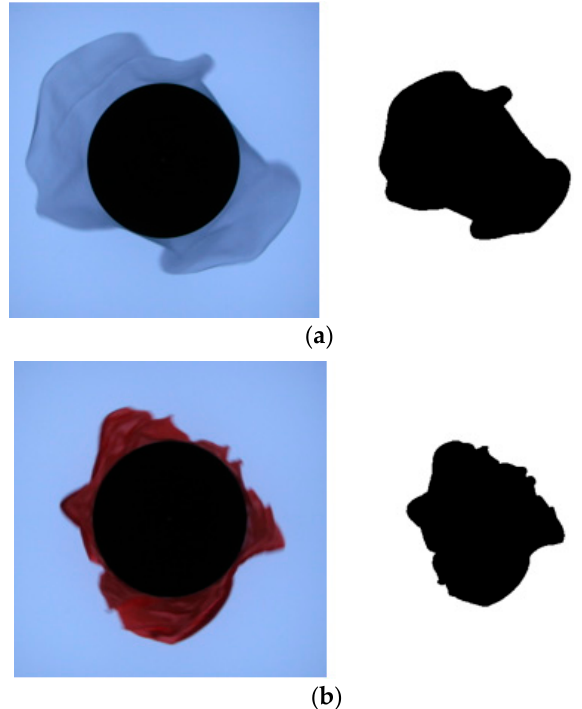
Figure 10. Drape properties of undyed and dyed warp-knitted fabrics: ( a ) Undyed; ( b ) dyed.